Question: State the chart type depicted above.
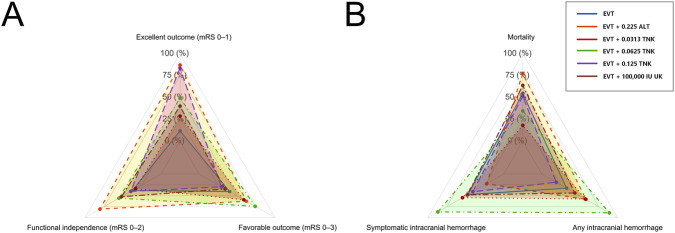
Answer: line